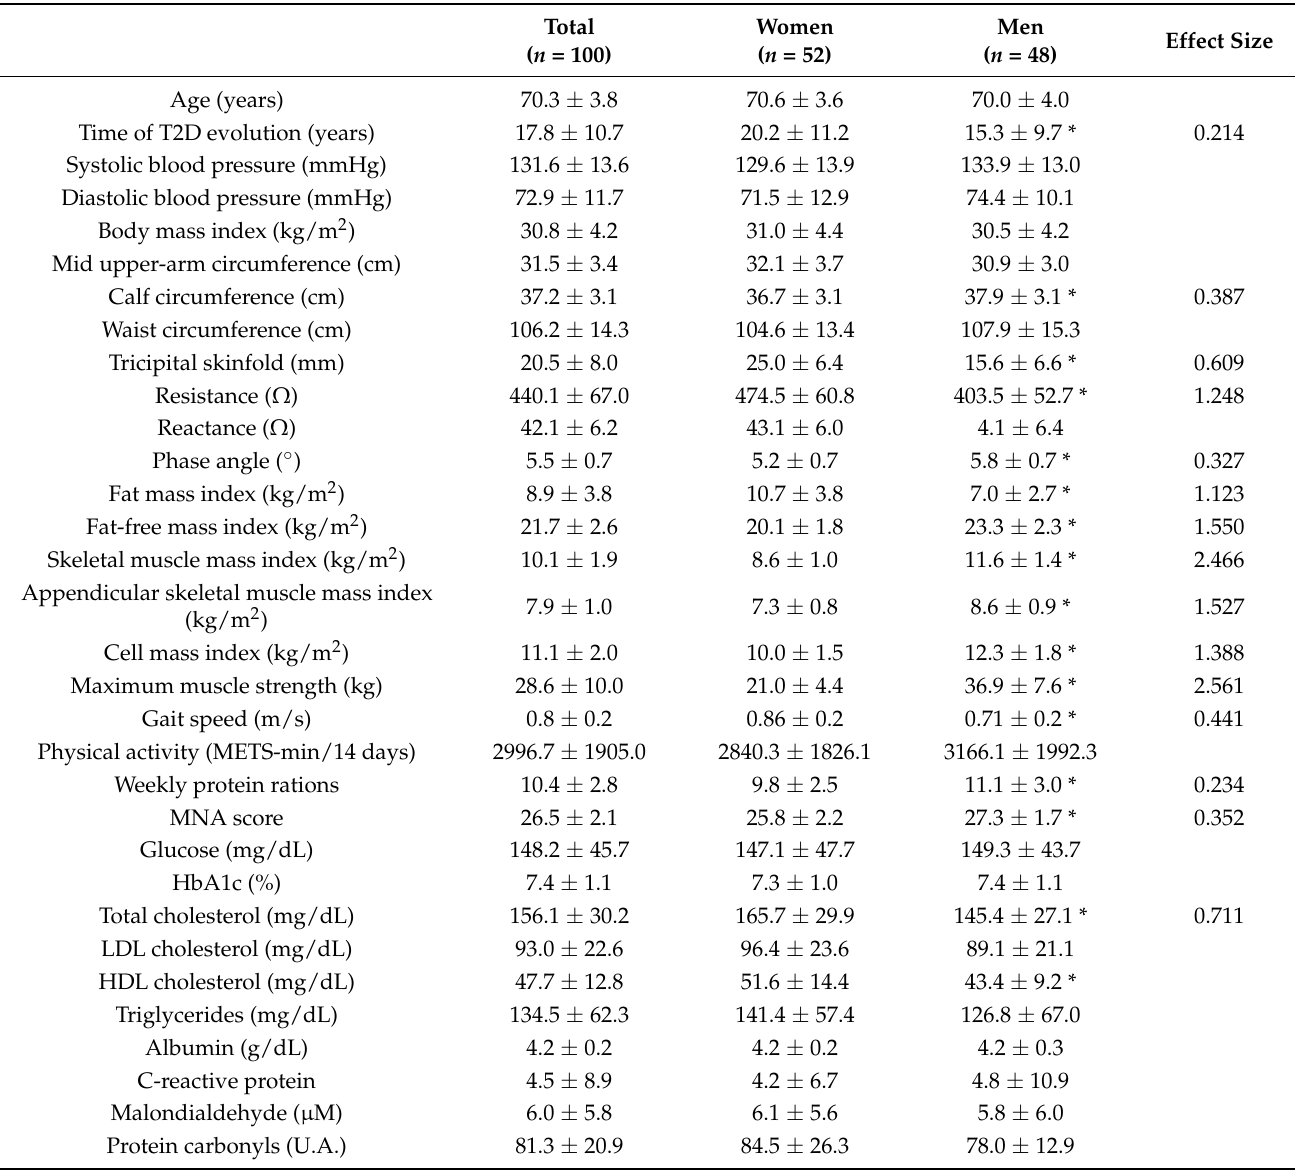
Table 1. Characteristics of the patients with type 2 diabetes included in the study.